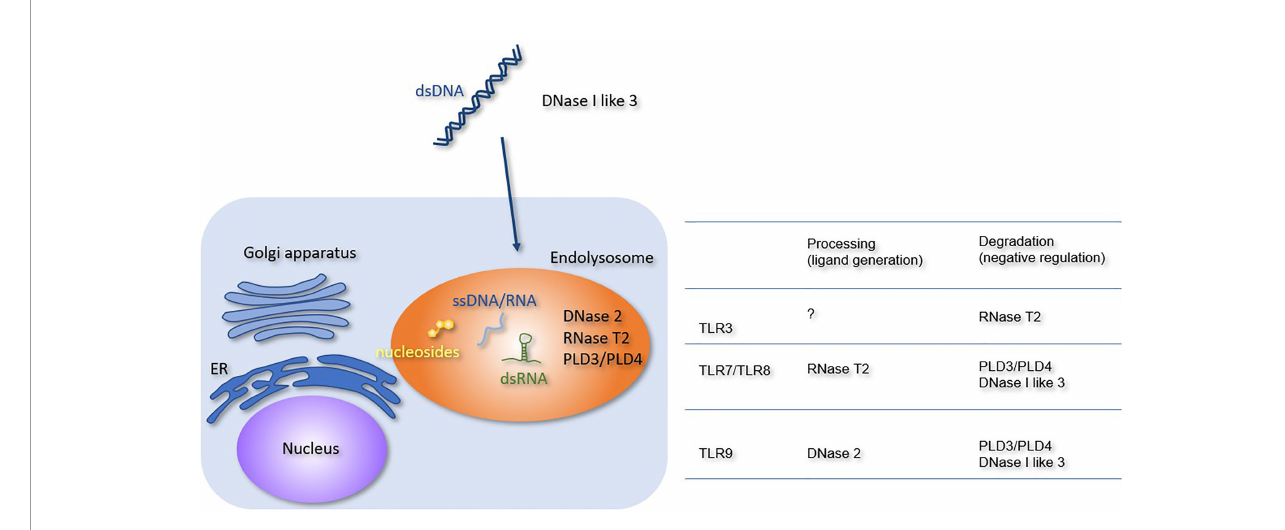
FIGURE 1 | Processing or degradation of TLR ligands by DNases and RNases. The extracellular and lysosomal enzymes involved in NA metabolism are shown. The Table summarizes the role of each enzyme in TLR responses. RNase T2 negatively regulates TLR3 responses but is required for TLR7 and TLR8 responses. PLD3, PLD4, and DNase I-like 3 negatively regulate TLR7, TLR8, and TLR9 responses. DNase 2 is required for TLR9